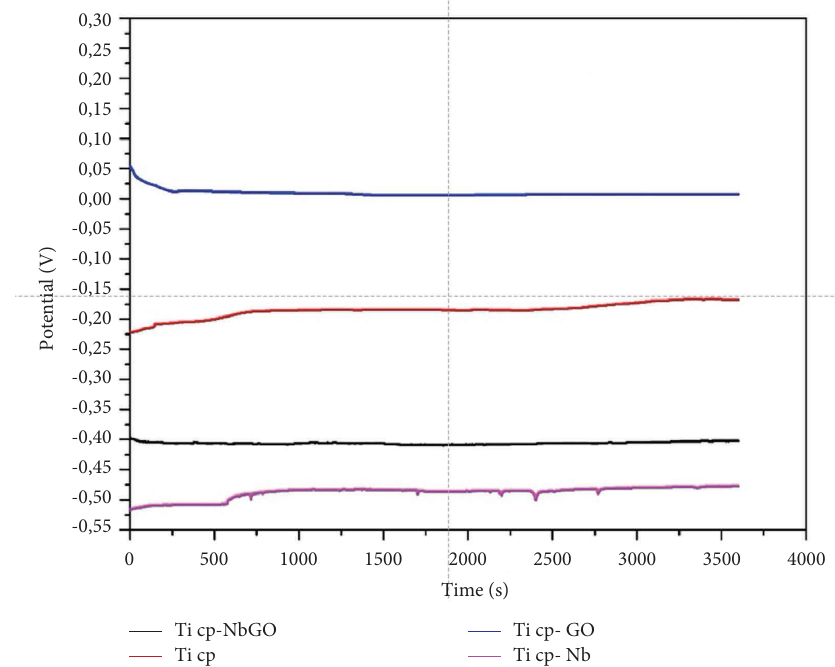
Figure 9: Open circuit potential measurement for cp Ti, cp Ti-GO, cp Ti-NB, and cpTi-NBGO in a physiological solution containing 0.9%